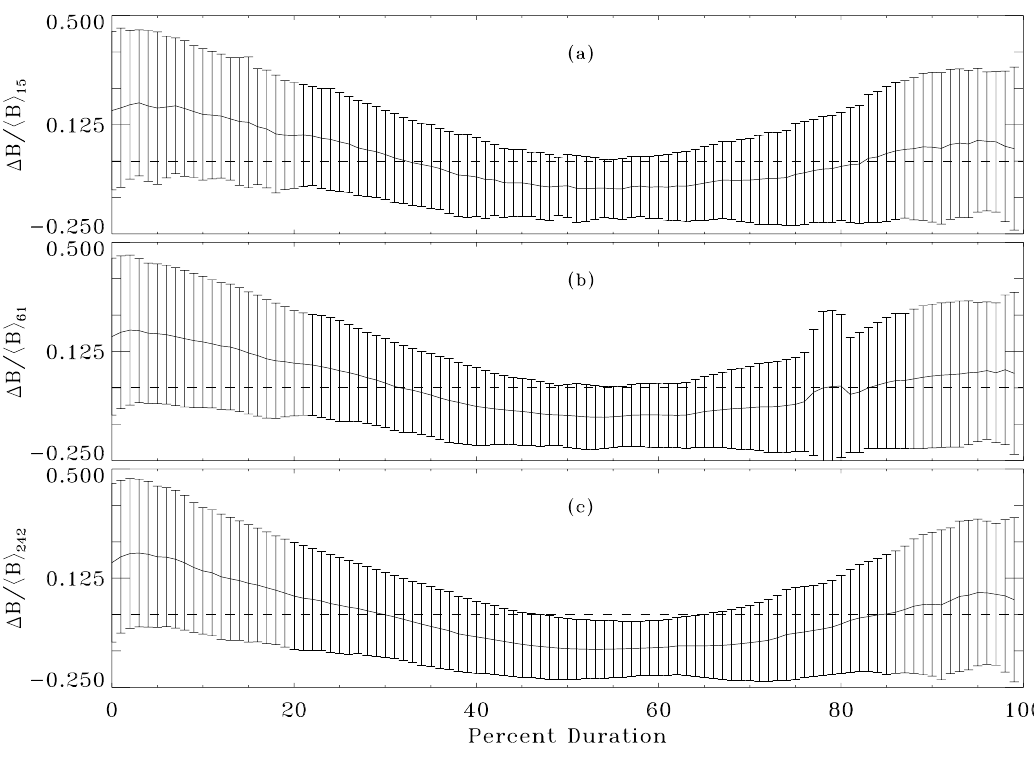
Fig. 3. Family of plots of 1B / <B> (i.e., 1B normalized by average B-magnitude) vs. %-duration for three 1T s (from top to bottom as in Fig. 1a, b, c), as shown by the subscripts on the ( 1B / <B>) s on the left). The central curves are the actual averages over the 50 MCs, and the lengths (top-to-bottom) of the vertical bars at the points represent twice their sigmas. The dashed line is the